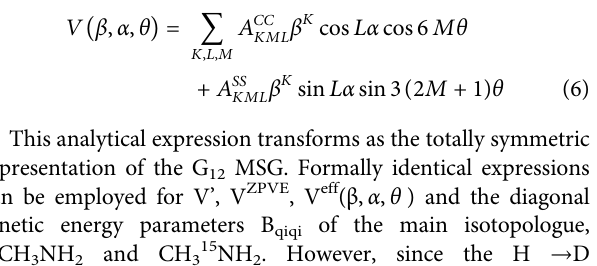
Frontiers in Chemistry |